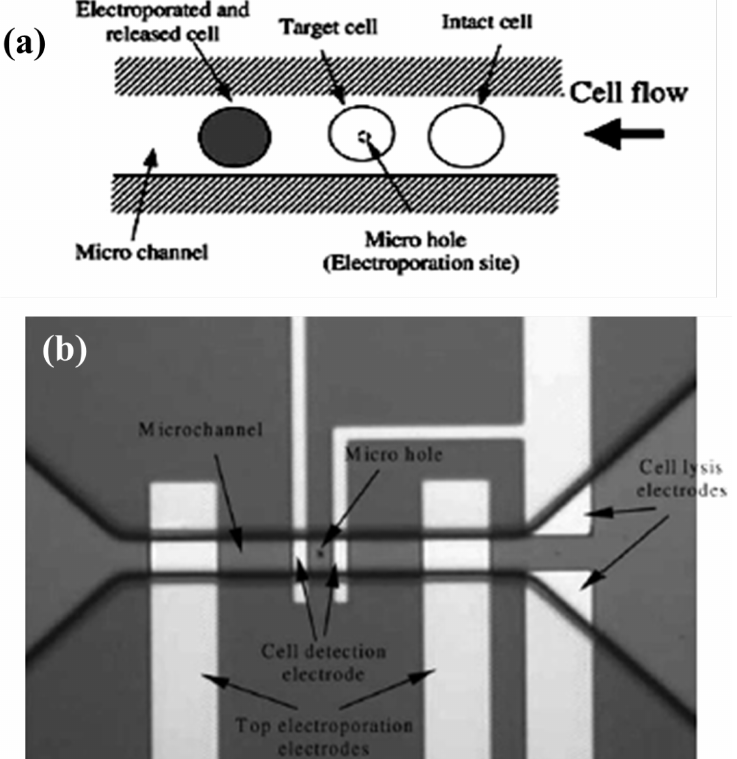
Figure 6. ( a ) Concept of flow through micro-electroporation chip; ( b ) Optical image of micro-channel, micro-hole and electrodes. Permission to reprint obtained from Elsevier [78].